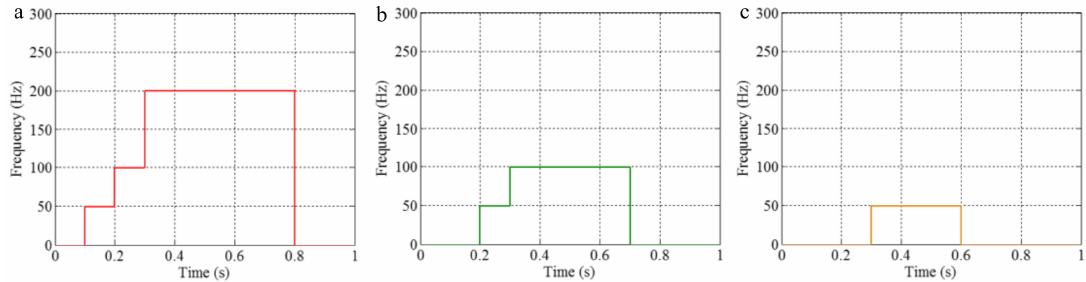
Figure 11. The ideal time-frequency distributions of the IMFs 1–3: ( a ) IMF 1; ( b ) IMF 2 and ( c ) IMF 3.